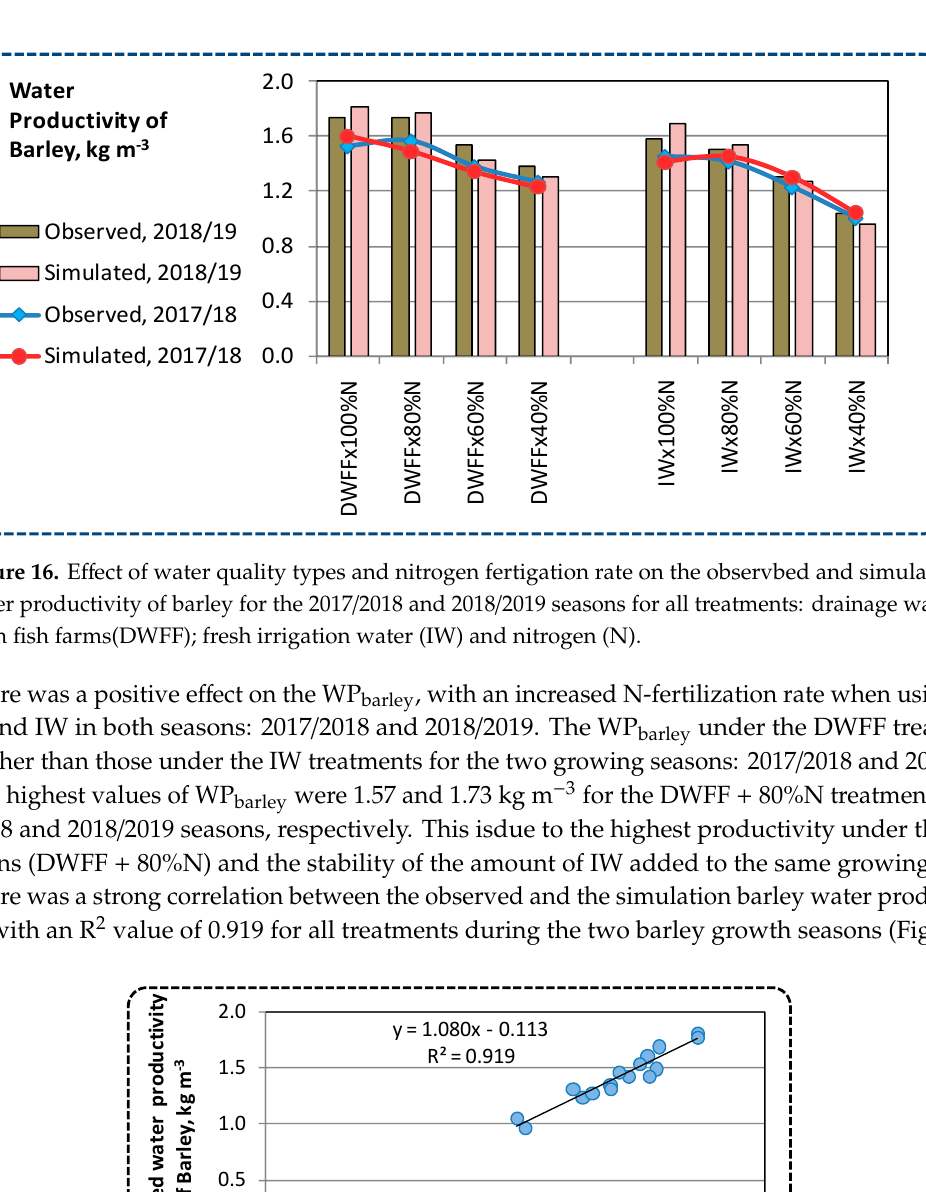
barley were 1.57 and 1.73 kg m − 3 for the DWFF + 80%N treatment for the